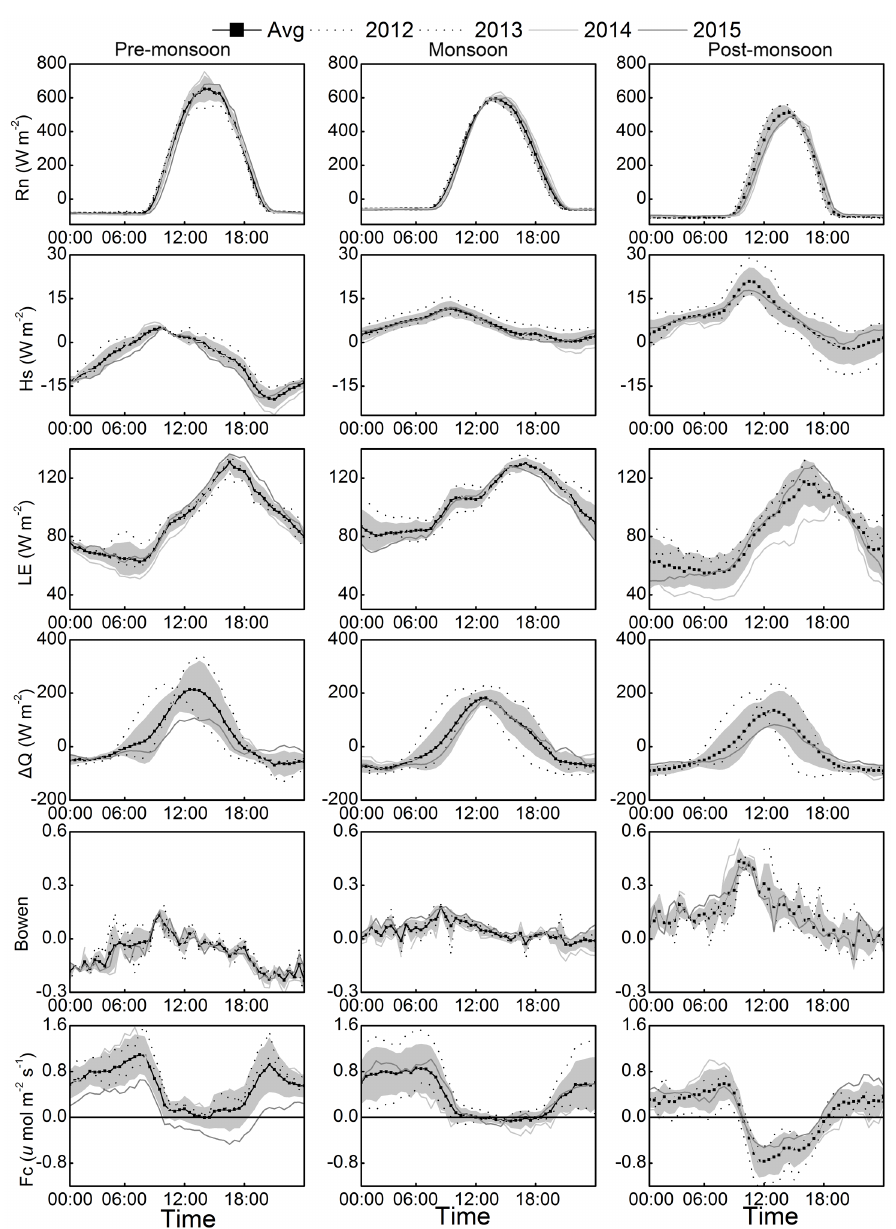
Figure 8. The average diurnal patterns of energy balance components (the net radiation flux, R n ; the sensible heat flux, H s ; the latent heat flux, LE; and the storage heat flux in the lake, (cid:49)Q ), Bowen ratio (Bowen) and CO 2 flux ( F c ) during pre-monsoon, monsoon and post-monsoon periods from 2012 to